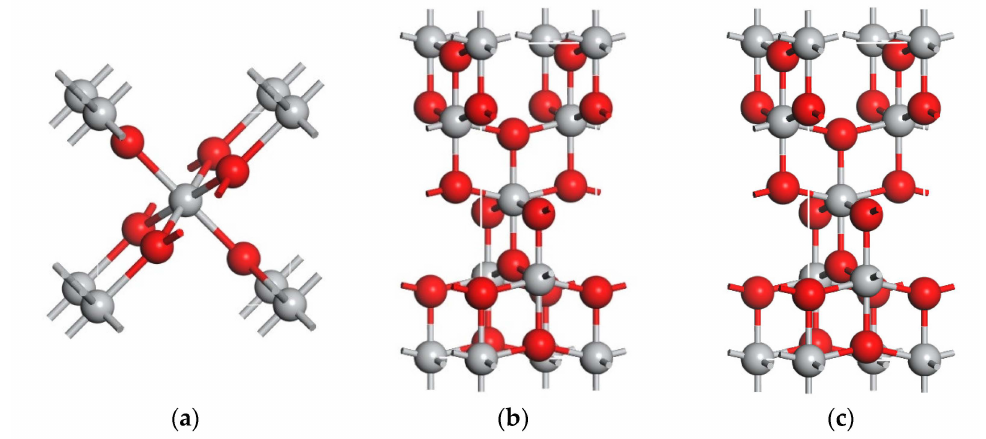
Figure 1. The crystal structure of TiO 2 (light gray atoms represent Ti; red atoms represent O): ( a ) rutile TiO 2 ; ( b ) anatase TiO 2 ; ( c ) brookite TiO 2 .